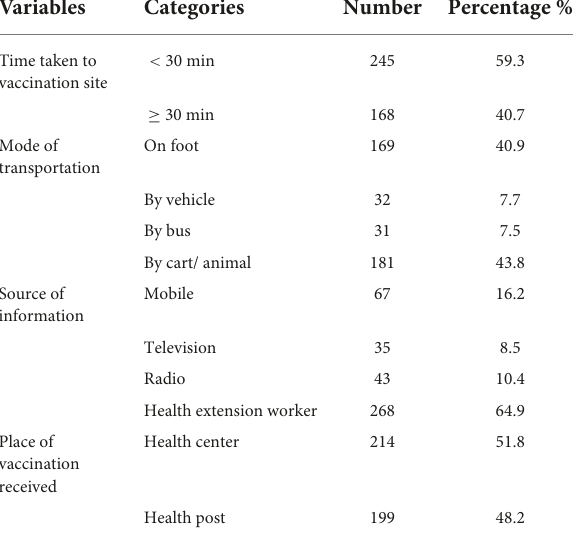
sick at the time of the vaccine schedule ( Figure 5 : perceived reasons for not vaccinating children timely).